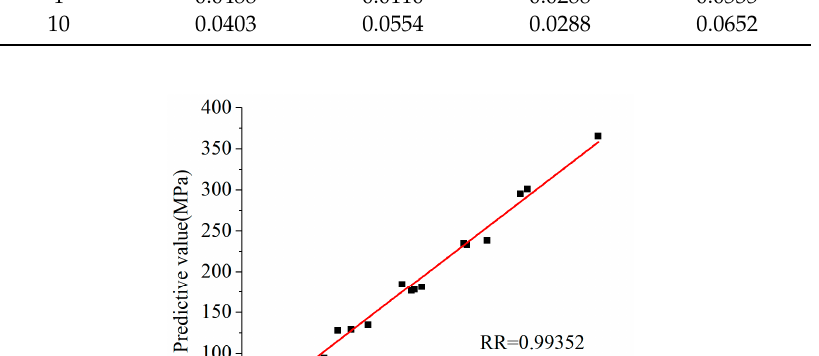
Figure 7. The correlation between experimental stress and predicted stress of the peak stress of 21-4N heat-resistant steel.